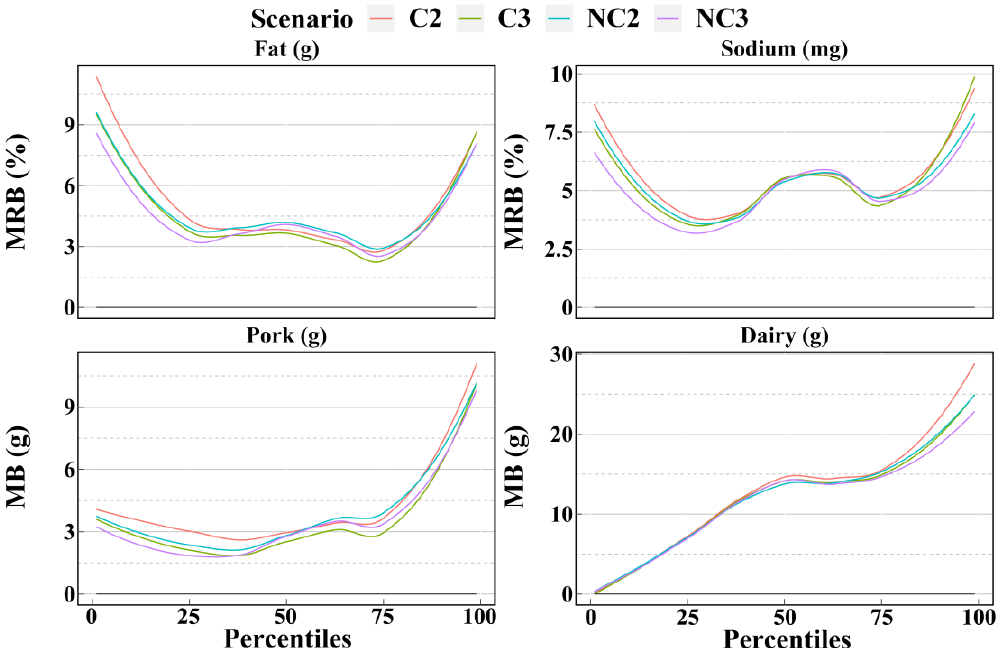
Figure 4. Smooth curves of the percentile (from 1st to 99th) intakes of dietary components in group 2 as calculated by the NCI method based on the 4 scenarios. Smooth curves of bias and relative bias for 10 dietary components calculated by the 4 scenarios are available in Supplementary Figure S3. C2 = 2 consecutive days; C3 = 3 consecutive days; NC2 = 2 non-consecutive days; NC3 = 3 non- consecutive days; MRB = Mean relative bias; MB = Mean bias.